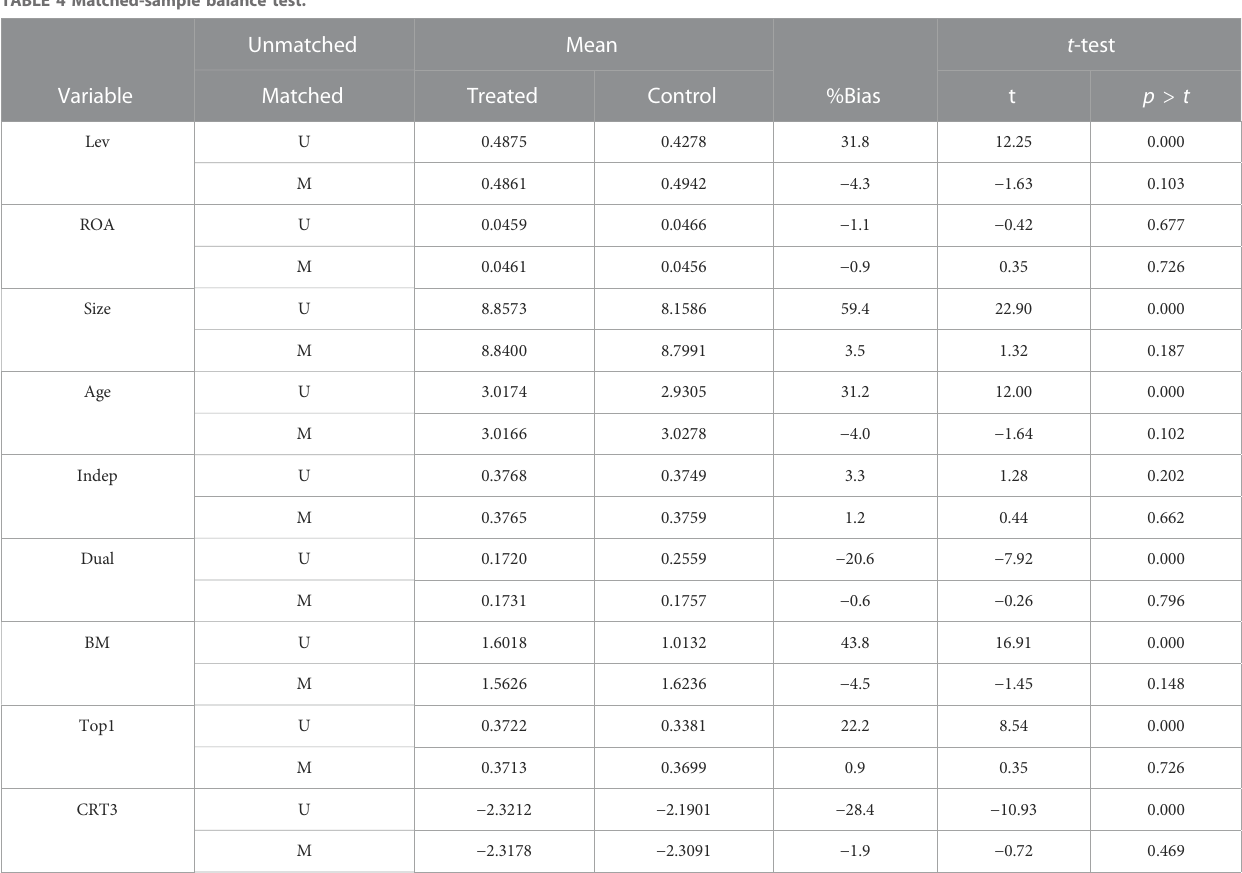
TABLE 4 Matched-sample balance